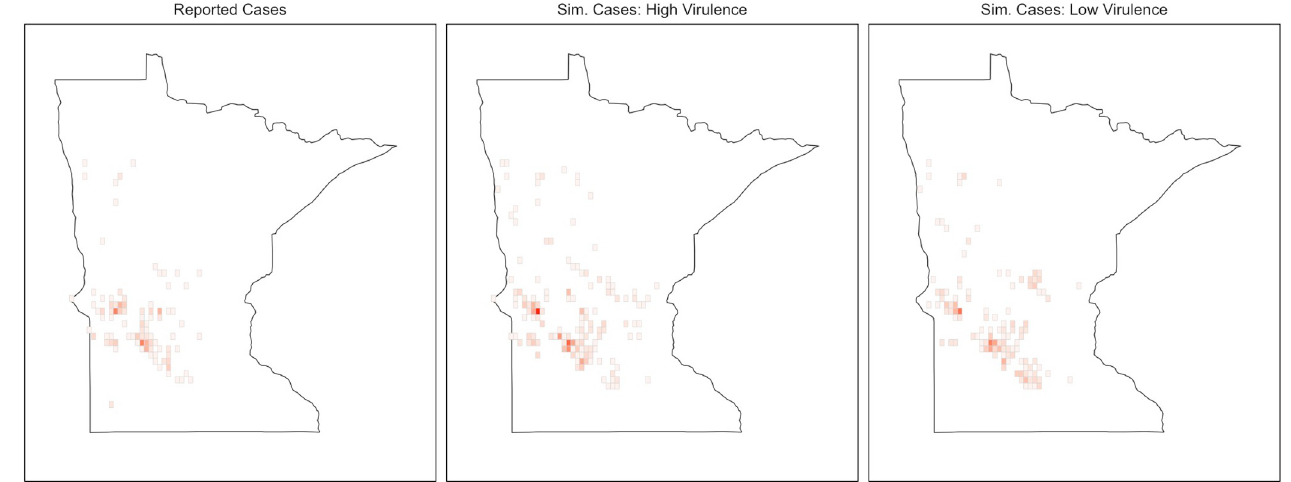
Fig 3. Spatial distribution of reported PRRS cases (2012–2014), and simulated PRRS cases for a high and a low virulent strain.